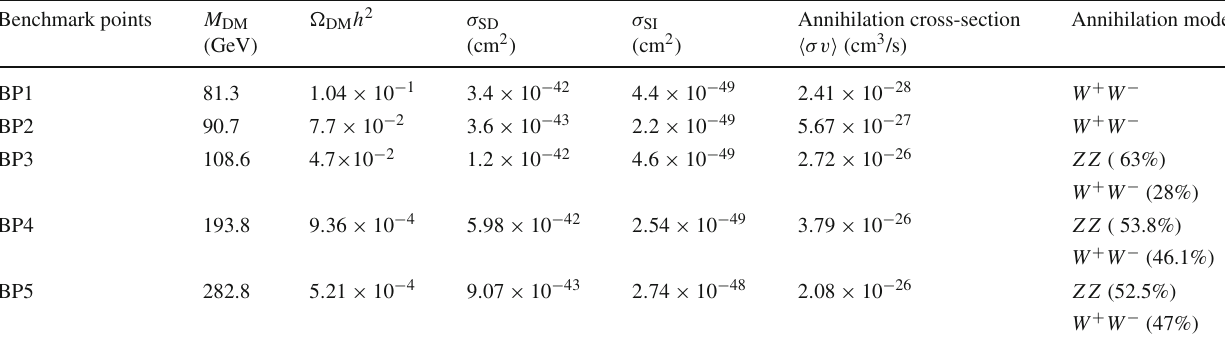
Table 3 DM masses along with DM relic density, spin-dependent, spin-dependent cross-sections, thermally averaged annihilation cross-sections and dominant annihilation modes for five benchmarks Benchmark points M DM Annihilation cross-section Annihilation mode ( GeV